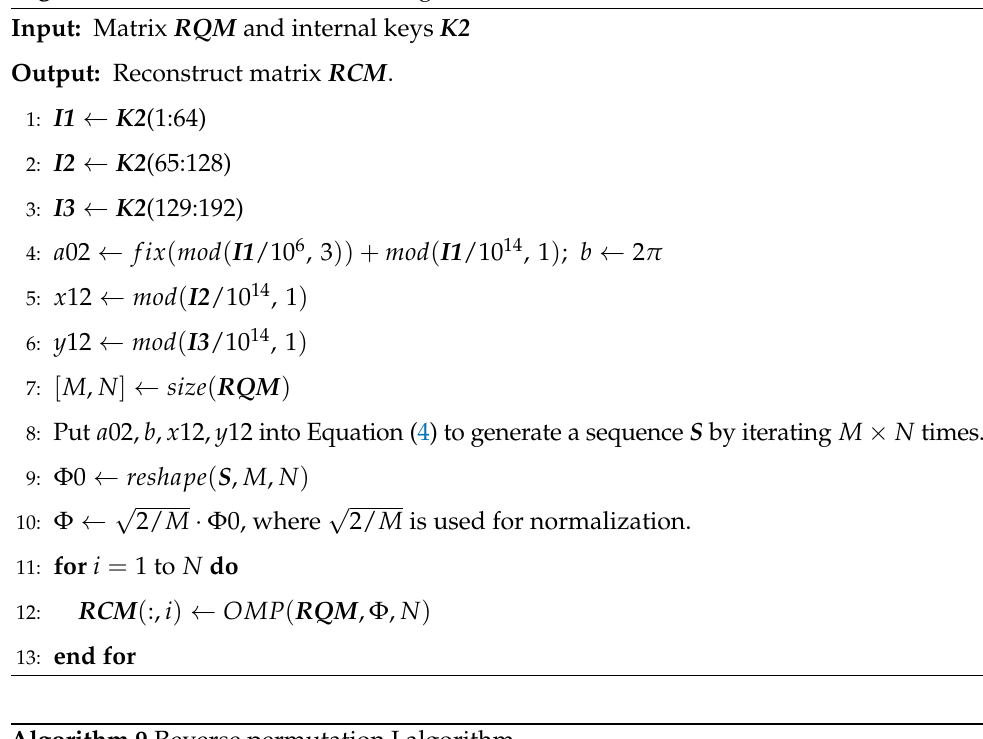
Algorithm 8 Matrix reconstruction algorithm